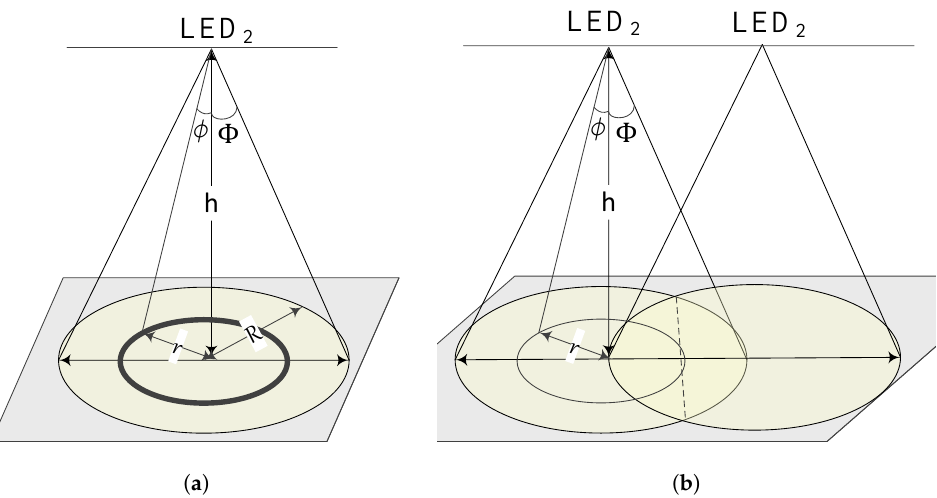
Figure 5. Set-ups to show the effect of full angle on positioning. ( a ) Effect in a single LED positioning system, ( b ) the effect in the overlap system with two identical